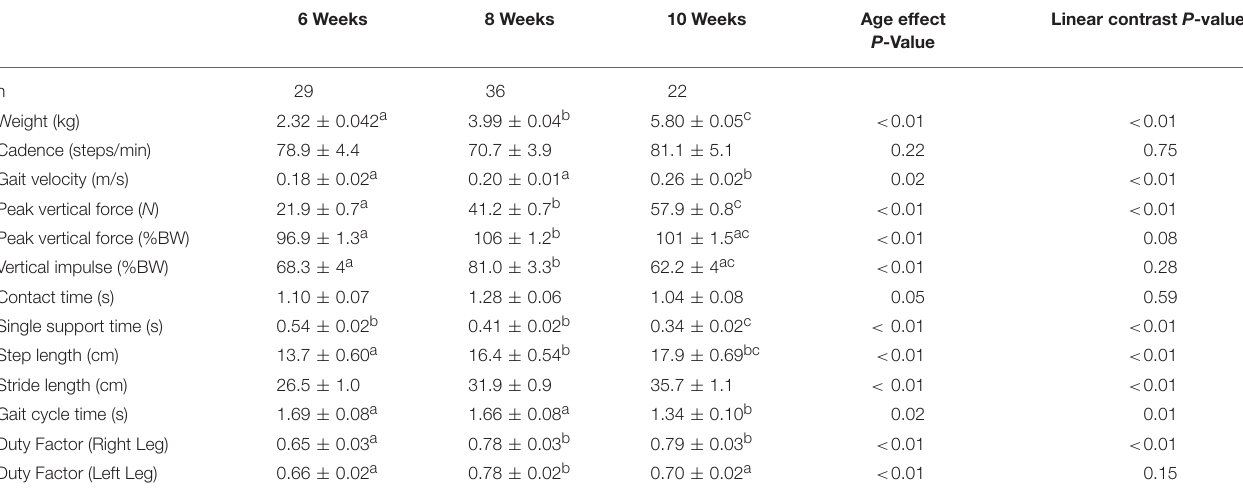
TABLE 2 | Number of turkey hens, average body weight, and gait parameters collected at three different ages via the pressure sensing walkway.